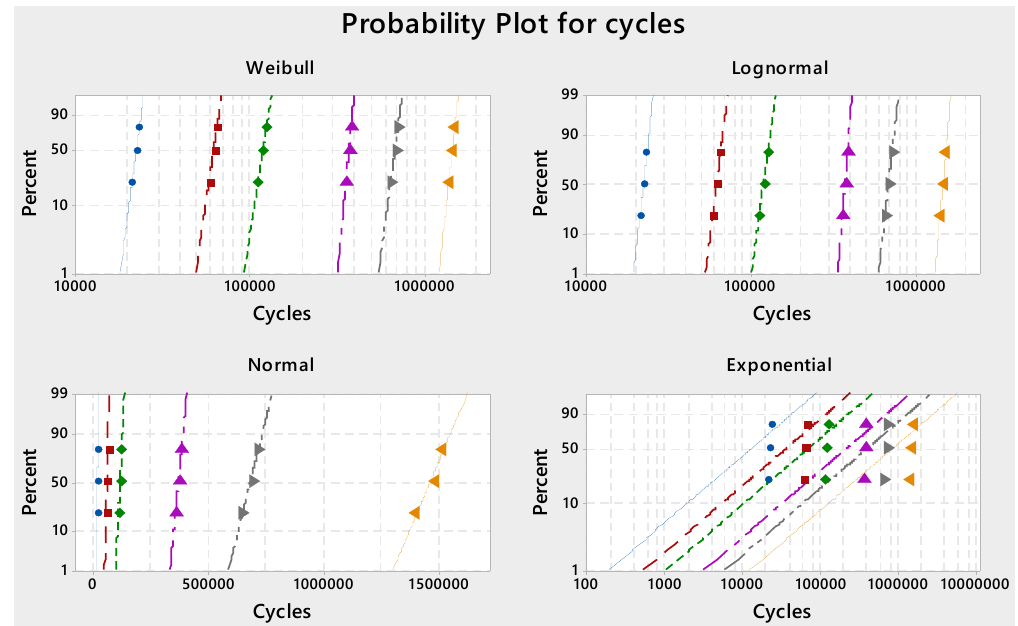
Figure 4. Different distributions for Anderson–Darlin (A–D) values. Table 4. Results of Anderson–Darling values for fatigue life. Stress Max.